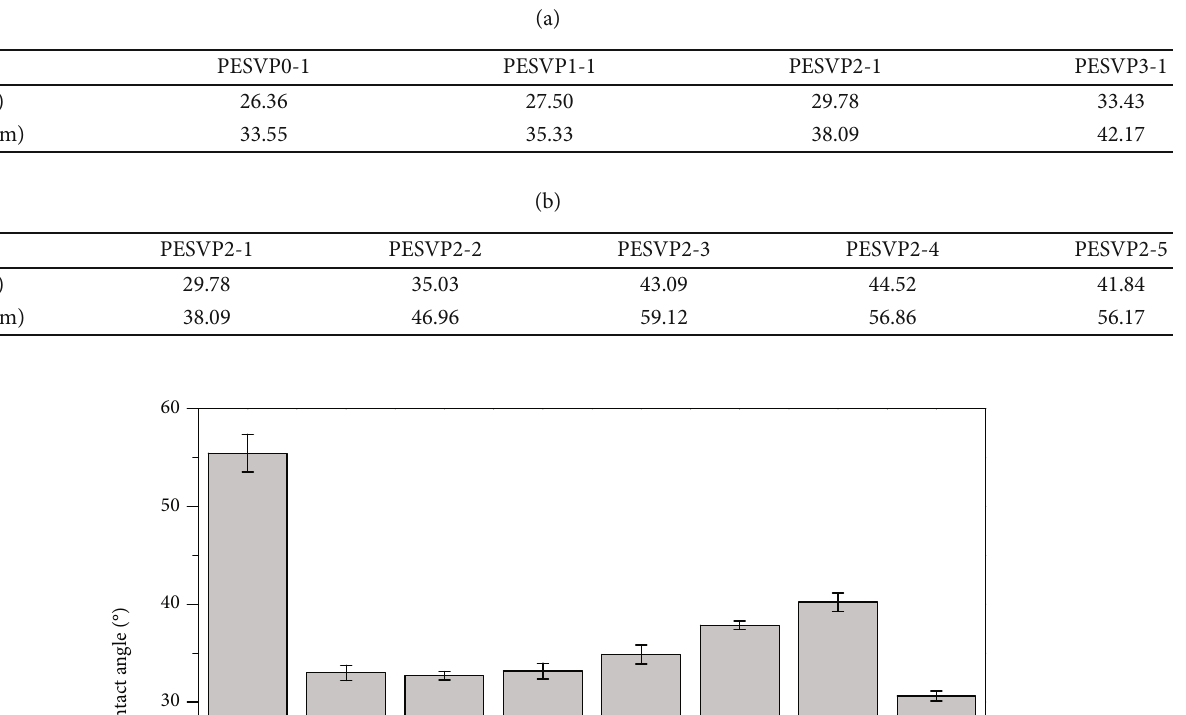
Table 3: Surface roughness results of PESVP membranes.